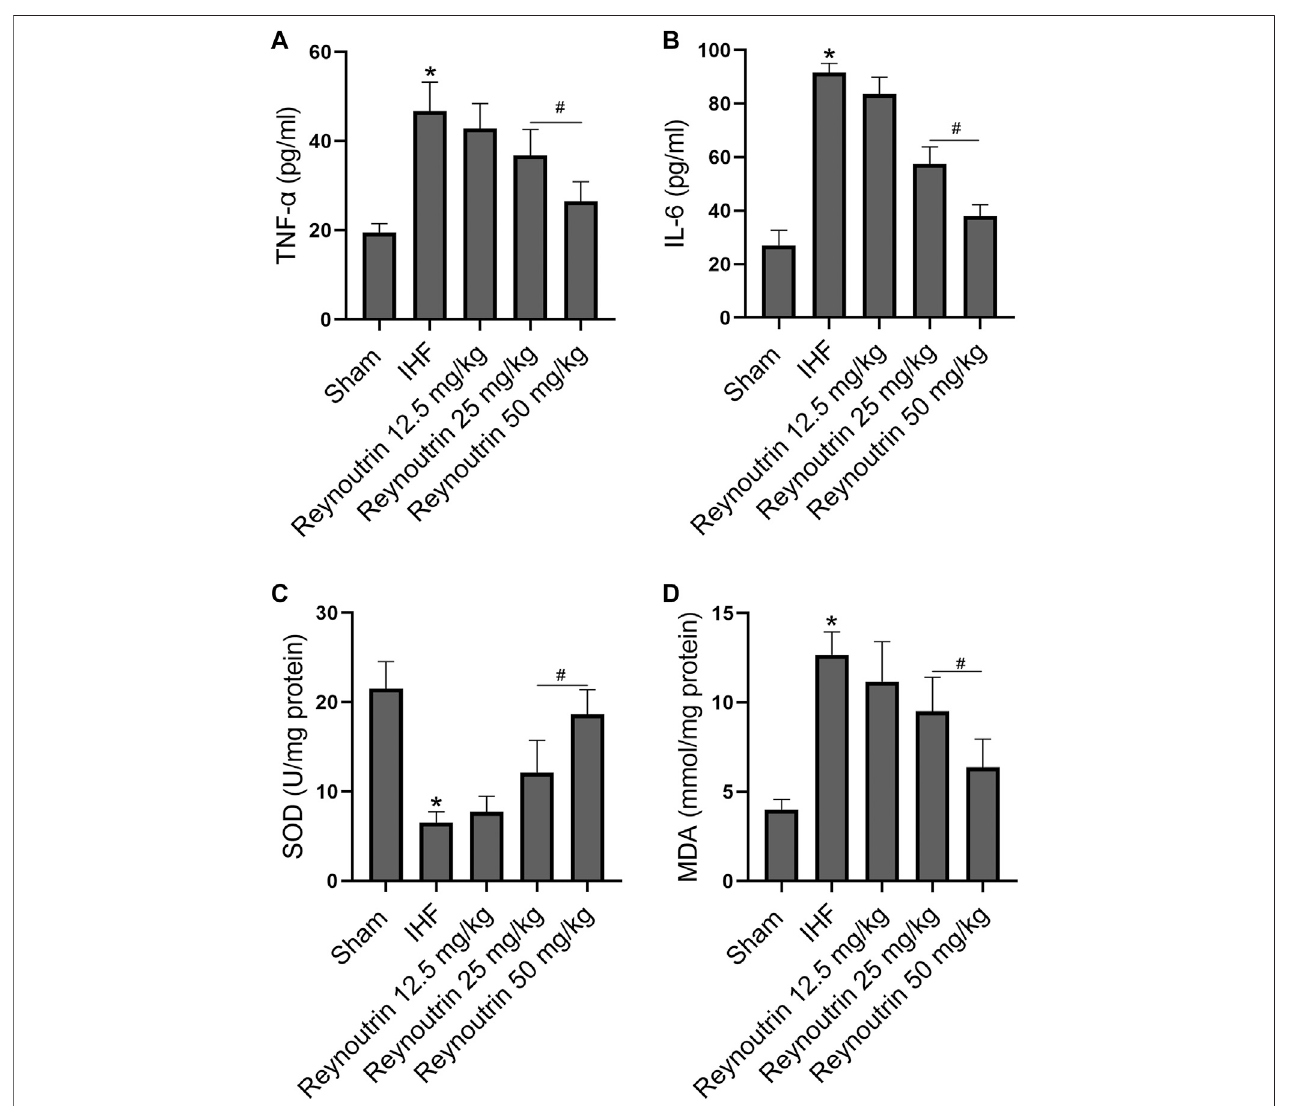
FIGURE3| EffectsofreynoutrinonthelevelsofTNF- α ,IL6,SODandMDAinrats. (A) TheconcentrationofTNF- α inserumofeachgroup. (B) Theconcentrationof IL six in serum of each group. (C) The concentration of SOD in myocardium of each group. (D) The concentration of MDA in myocardium of each group. The values presented as the means ± standard error in each experiment group ( n (cid:1) 10). * p < 0.05 vs. Sham group; # p < 0.05 vs. IHF group.